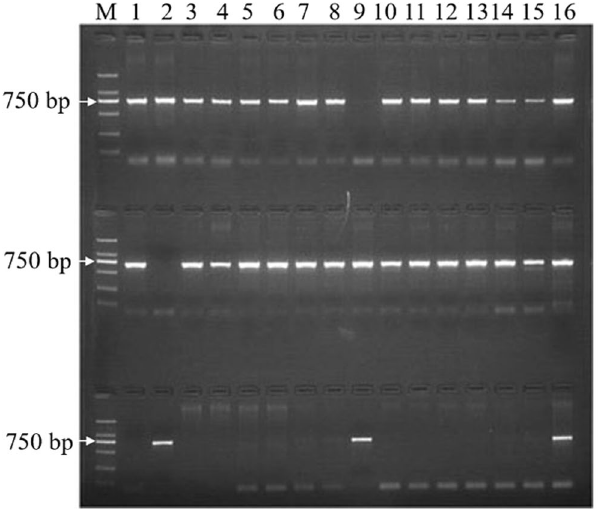
Figure 5. Determination of the chromosome location of TaARG genes using Langdon–Chinese Spring chromosome substitution lines. M: DL2000 DNA ladder (TianGen Biotech (Beijing) Co., Ltd.). The locations of TaARG s on chromosomes 2AS, 2BS, and 2DS, are shown in the top, middle, and bottom panels, respectively. Lanes 1–16: LDN-1D(1B), LDN-2D(2B), LDN-3D(3B), LDN-4D(4B), LDN-5D(5B), LDN-6D(6B), LDN-7D(7B), LDN-1D(1 A), LDN-2D(2 A), LDN-3D(3 A), LDN-4D(4 A), LDN-5D(5 A), LDN-6D(6 A), LDN-7D(7 A), LDN, and CS. LDN: Langdon; CS: Chinese Spring. The photo was acquired by Quantity One softeware (BioRad, USA).